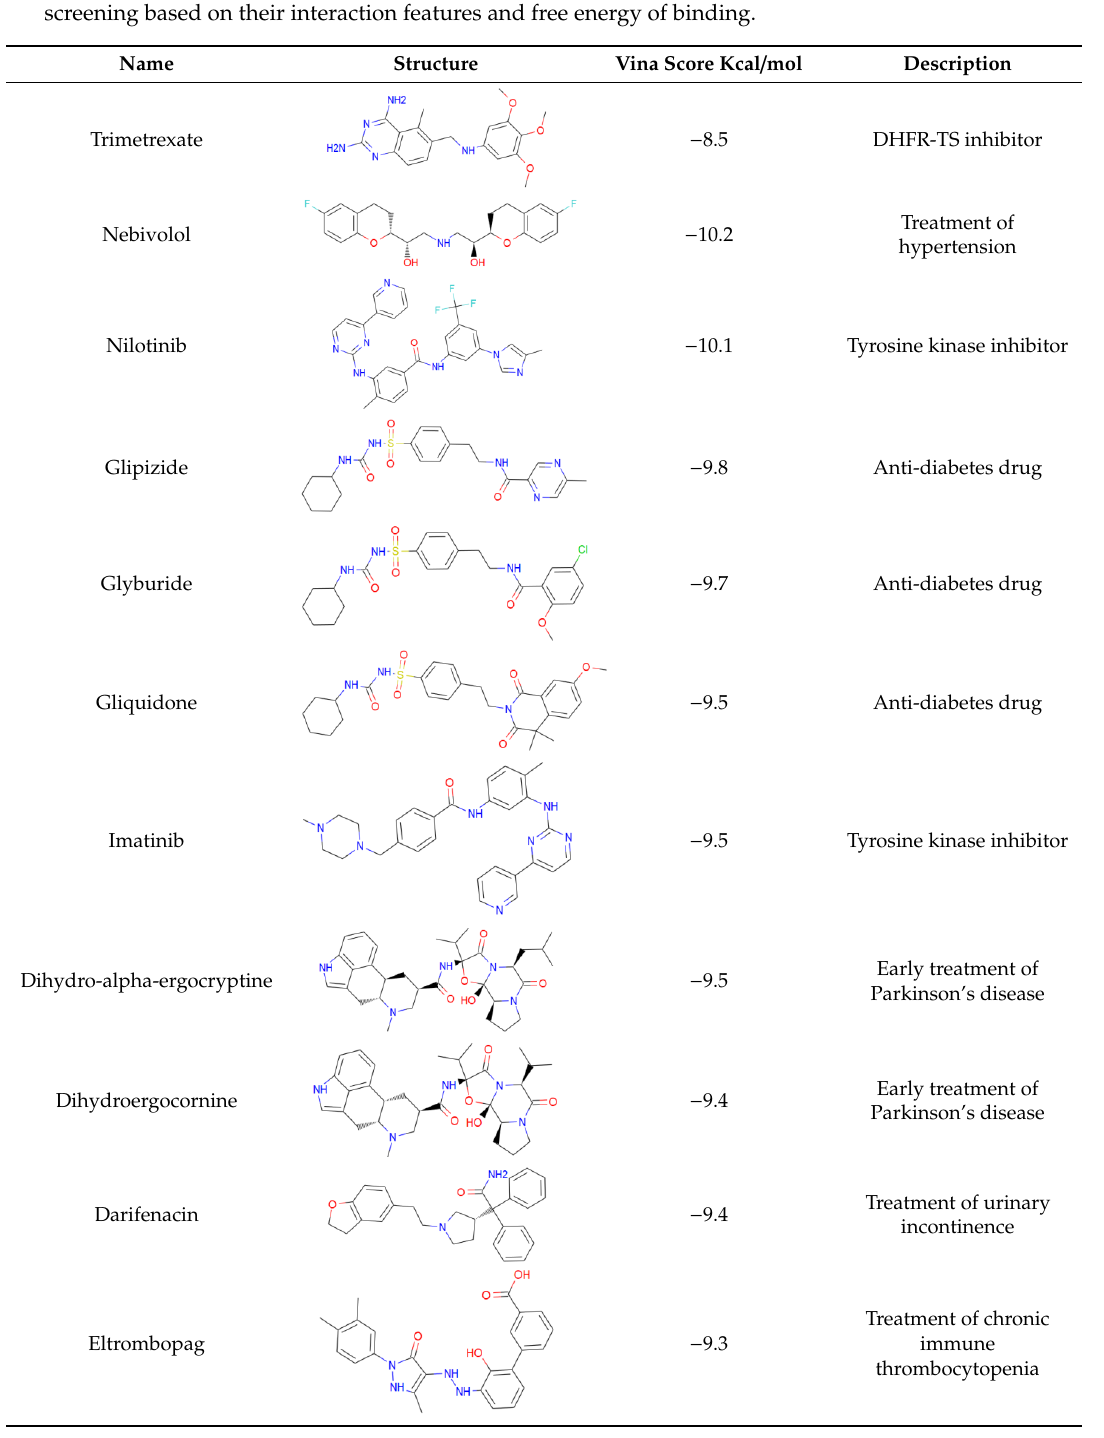
Table 3. Top ten food and drug administration (FDA)-approved drugs in the Tc DHFR-TS virtual screening based on their interaction features and free energy of binding.